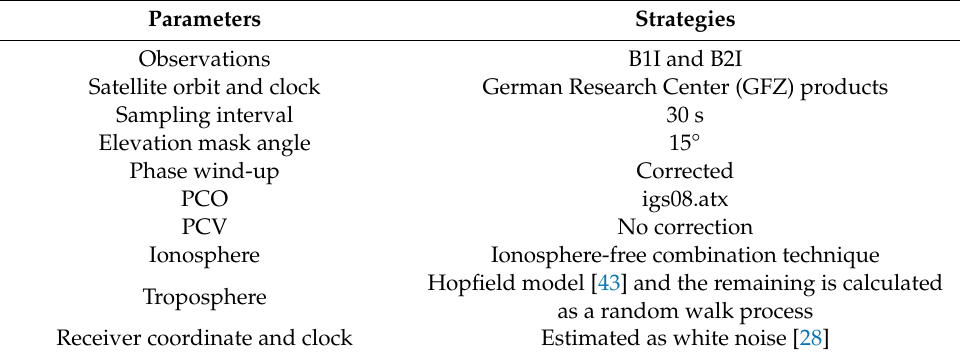
Figure 9. Disturbation of 10 GNSS stations in Hong Kong. Table 1. Detailed information of BDS PPP solution.